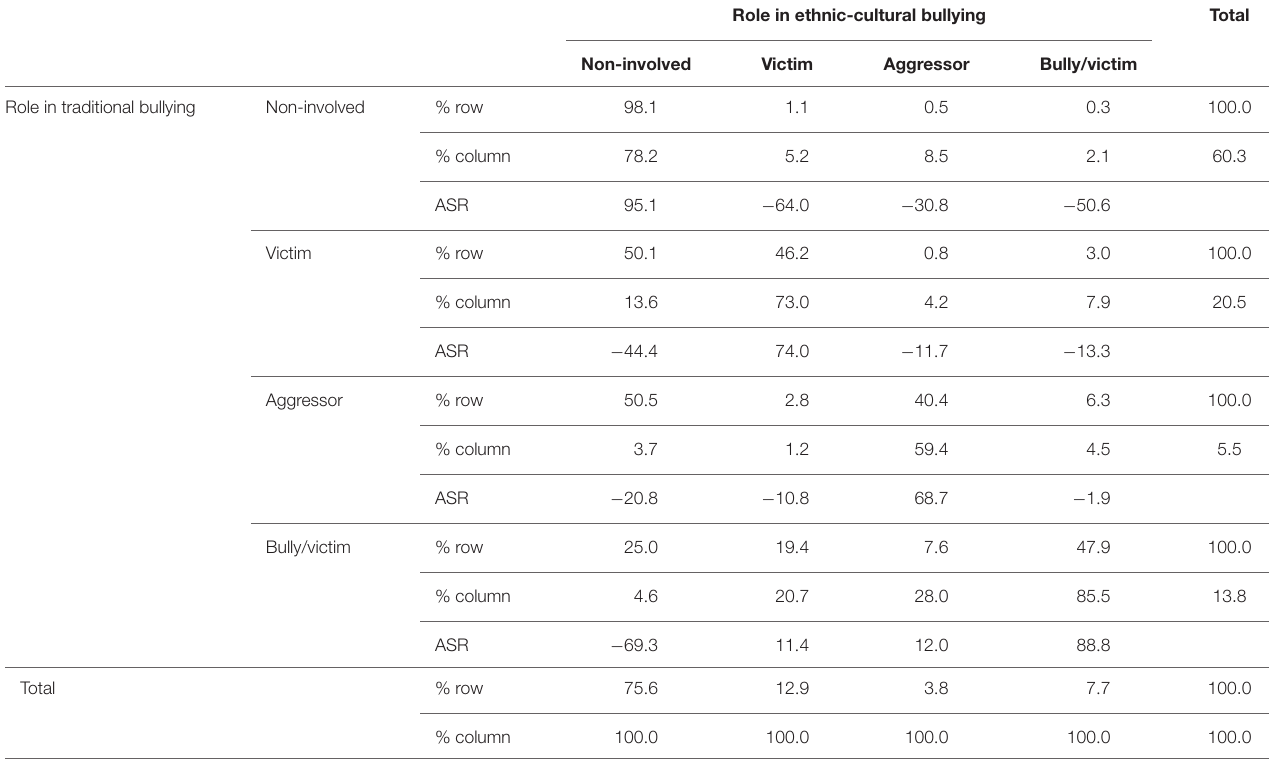
TABLE 5 | Overlap between traditional bullying and ethnic-cultural